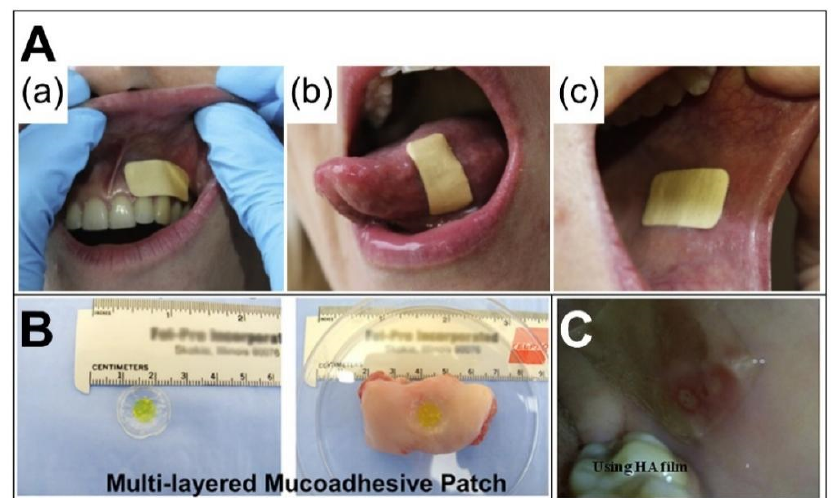
Figure 10. Application diagram of the oral film: ( A ) ( a ), ( b ) and ( c ) are different applied oral places [7]; ( B ) reprint permission from ref. [30]. Copyright 2019, American Chemical Society; ( C ) reprint permission from ref. [108]. Copyright 2020,